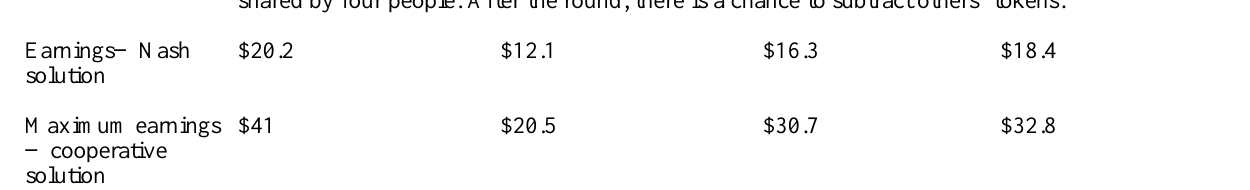
Low growth: P = 0.01 and an initial amount of 25% of the tokens on the screen.